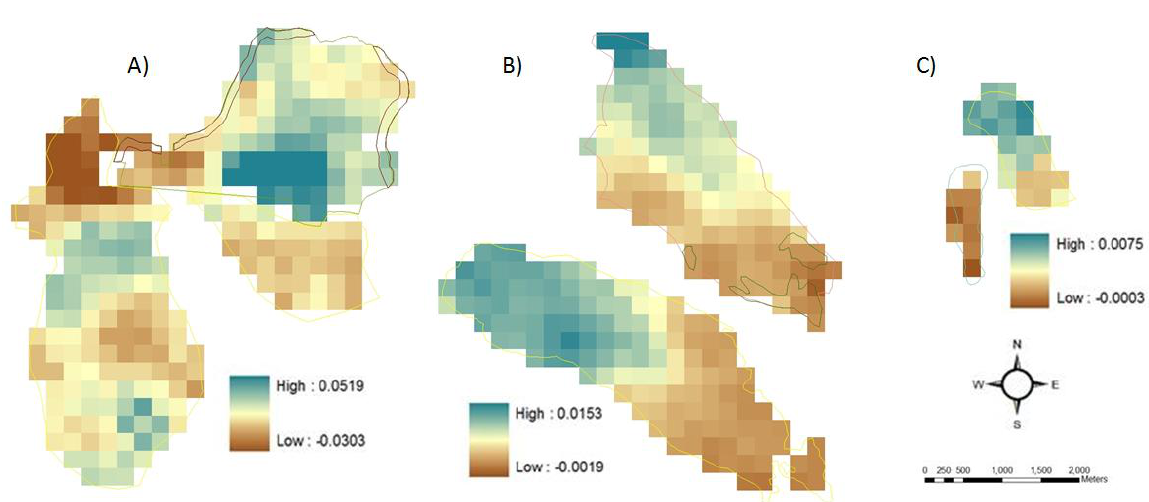
Figure 6. Monsoon trend for each pixel within the fire and the reference areas were computed. For Frijoles Canyon ( A ) the trend is calculated from 2008 to 2010, for Mid Elevation Mesas ( B ) from 2000 to 2010, and for Capulin ( C ) from 2006 to